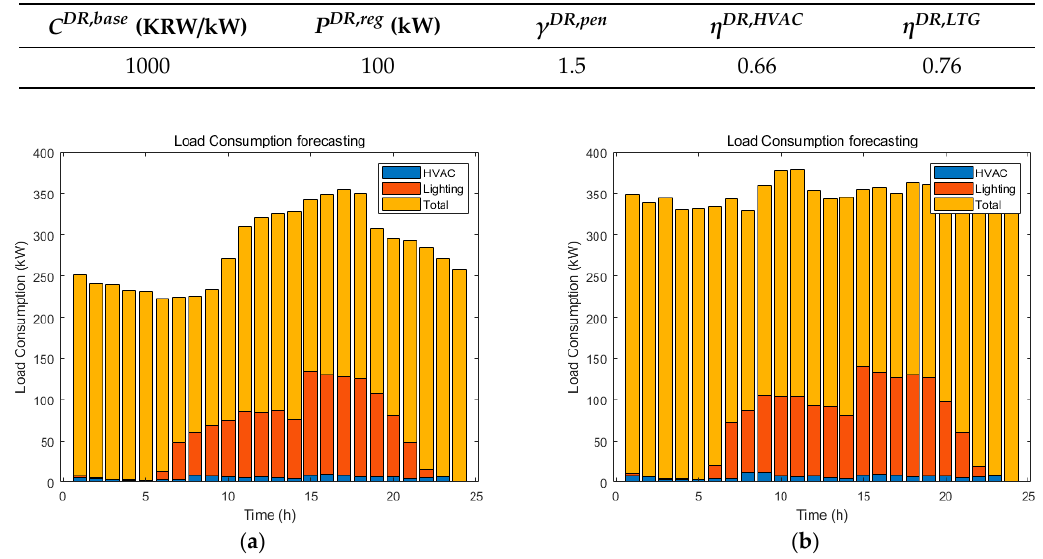
Table A4. DR data.